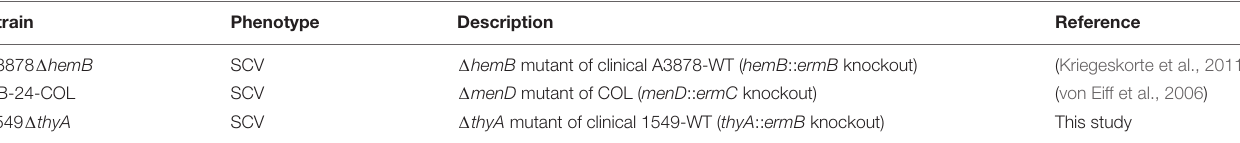
TABLE 3 | Genetically defined SCVs used as positive controls in auxotrophism